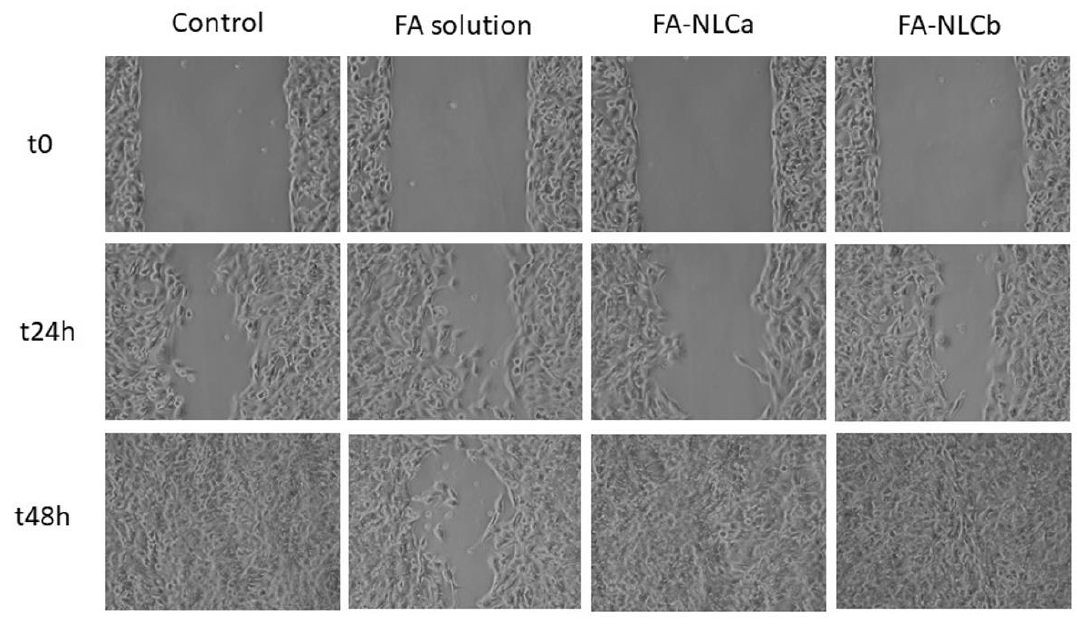
Figure 6. Photographs of the gaps among fibroblast cells at 0, 24, and 48 h after incubation with free FA, FA-loaded NLCa, and FA-loaded NLCb at 37 °C in 5% CO 2 and 95% relative humidity.